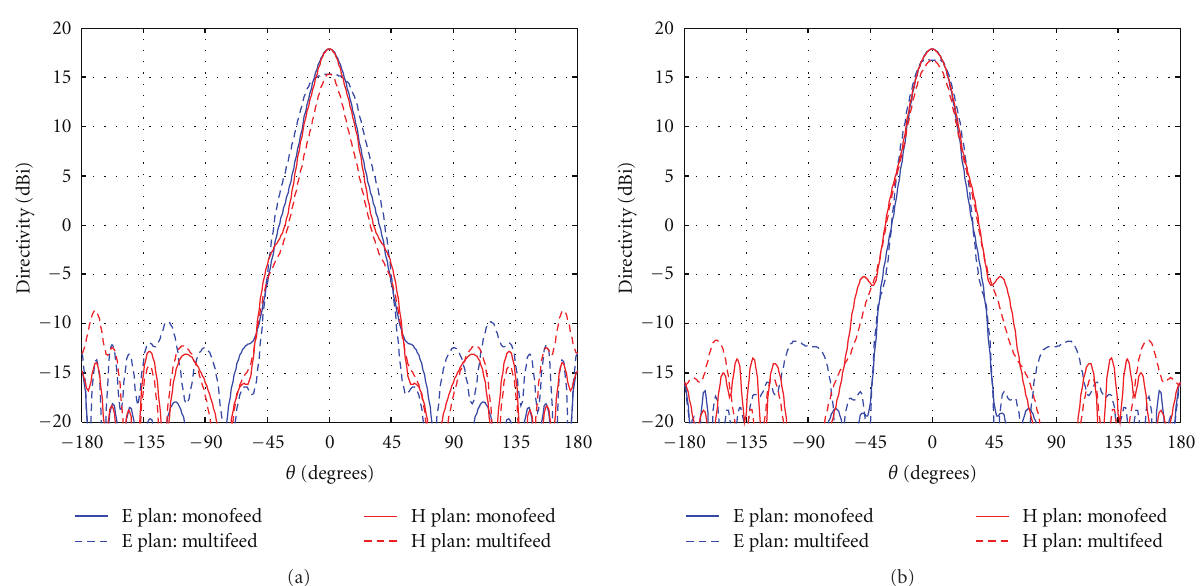
Figure 10: Radiation patterns at 5.05 GHz (a) and 7.58 GHz (b) in the E and H